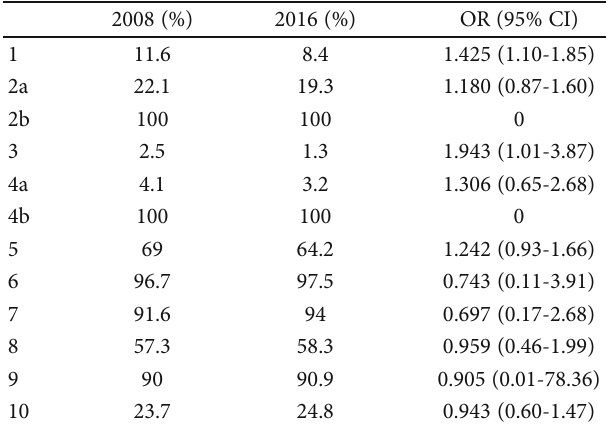
Table 8: Robson ’ s 10-Group Classi fi cation of a selected group of Flemish women giving birth in 2008 and 2016: cesarean section per group